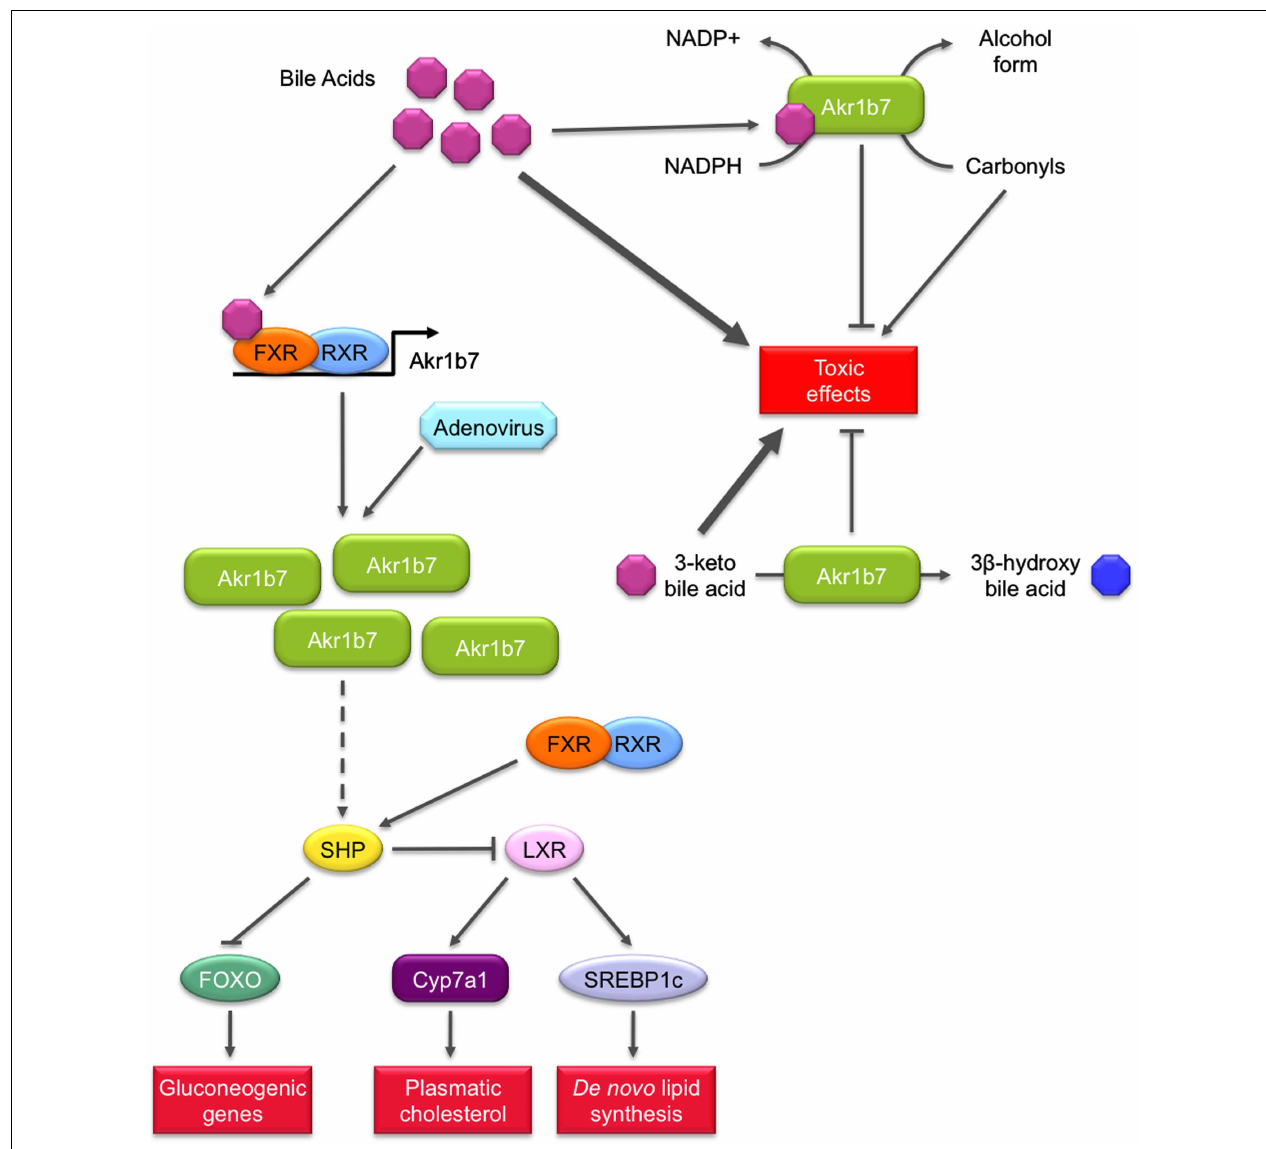
recombinant adenovirus results in the down-regulation of gluconeogenesis and lipid metabolism. Mechanisms involved are not unravel yet but could rely on the up-regulation of SHP expression. Increased SHP levels could in turn repress both FOXO and LXR, leading to the inhibition of gluconeogenic genes and lipogenic genes, respectively.The mechanism by which Akr1b7 accumulation modulates the SHP gene expression appears independent from FXR and remains to be discovered (dashed